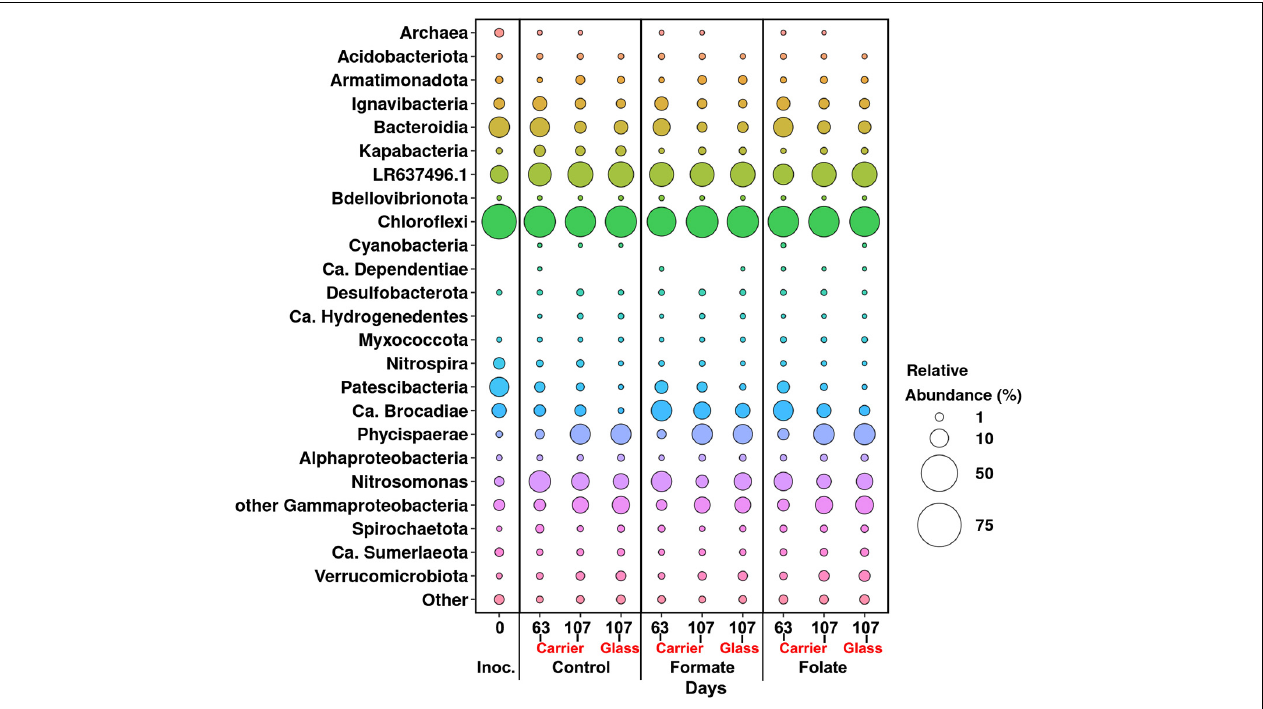
FIGURE 3 | Overall microbial diversity in the inoculum and the biomass on the carrier and on the walls of the reactors (glass) before (the 63rd day) and after (the 107th day) the additives supplied and the ammonium load increased (the first run of the reactors) as revealed by high-throughput sequencing of the 16S rRNA gene